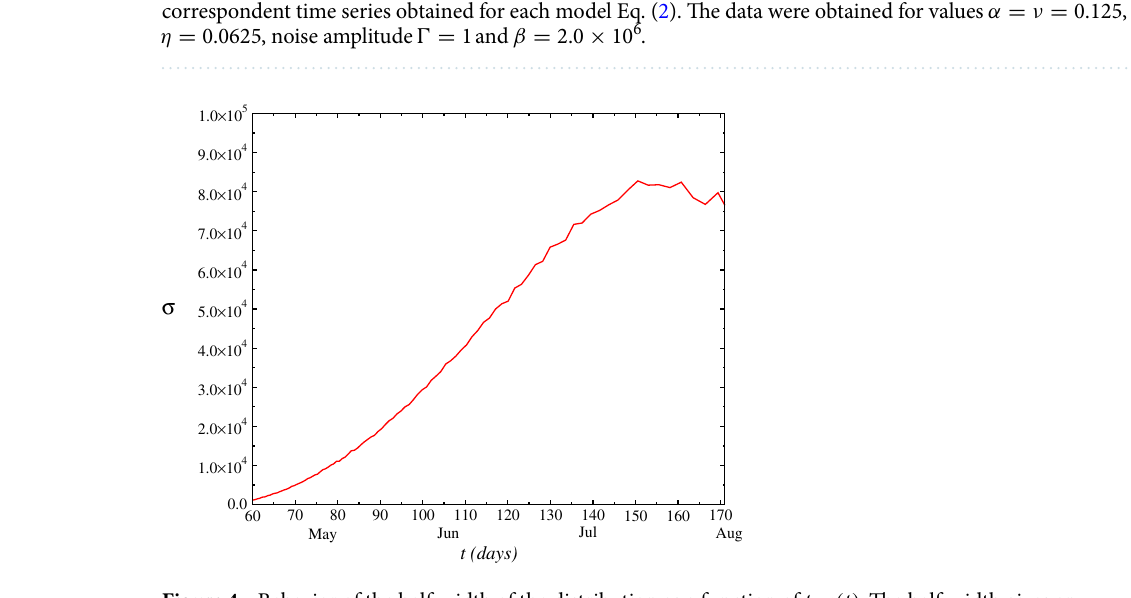
Figure 4. Behavior of the half-width of the distribution as a function of t , σ( t ) . The half-width gives an expectation of new cases in each day t